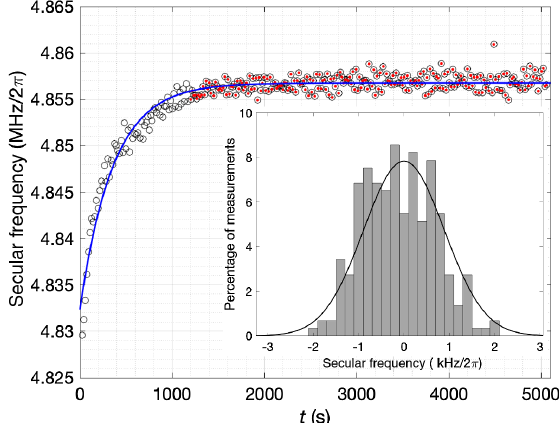
FIG. 8. Secular frequency over time during typical clock operation, as measured by the waveguide-coupled light tuned to the Δ m F ¼ 1 transition. Inset: histogram of the settled frequency (red points) difference from the fitted curve (blue line). The histogram is fitted to a Gaussian with σ ¼ 0 . 9